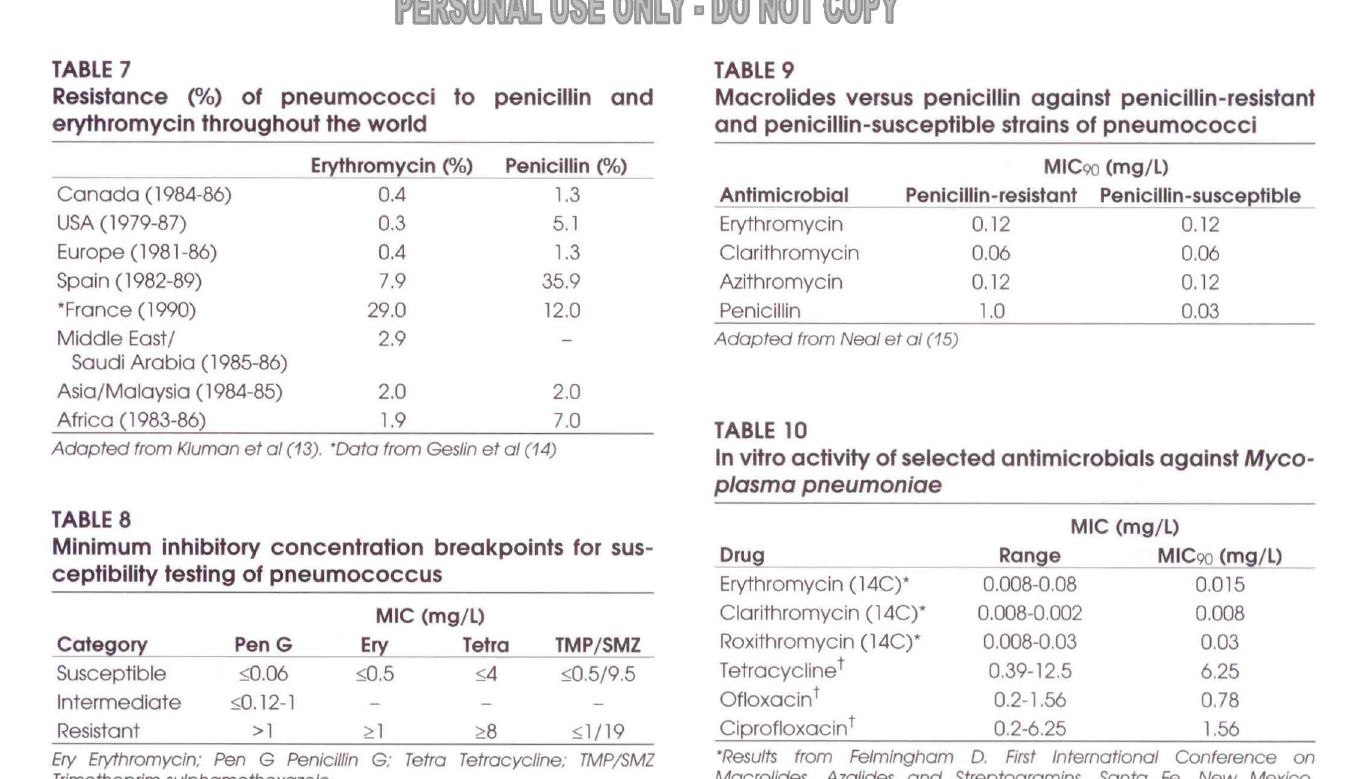
Minimum inhibitory concentration breakpoints for sus ceptibility testing of pneumococcus